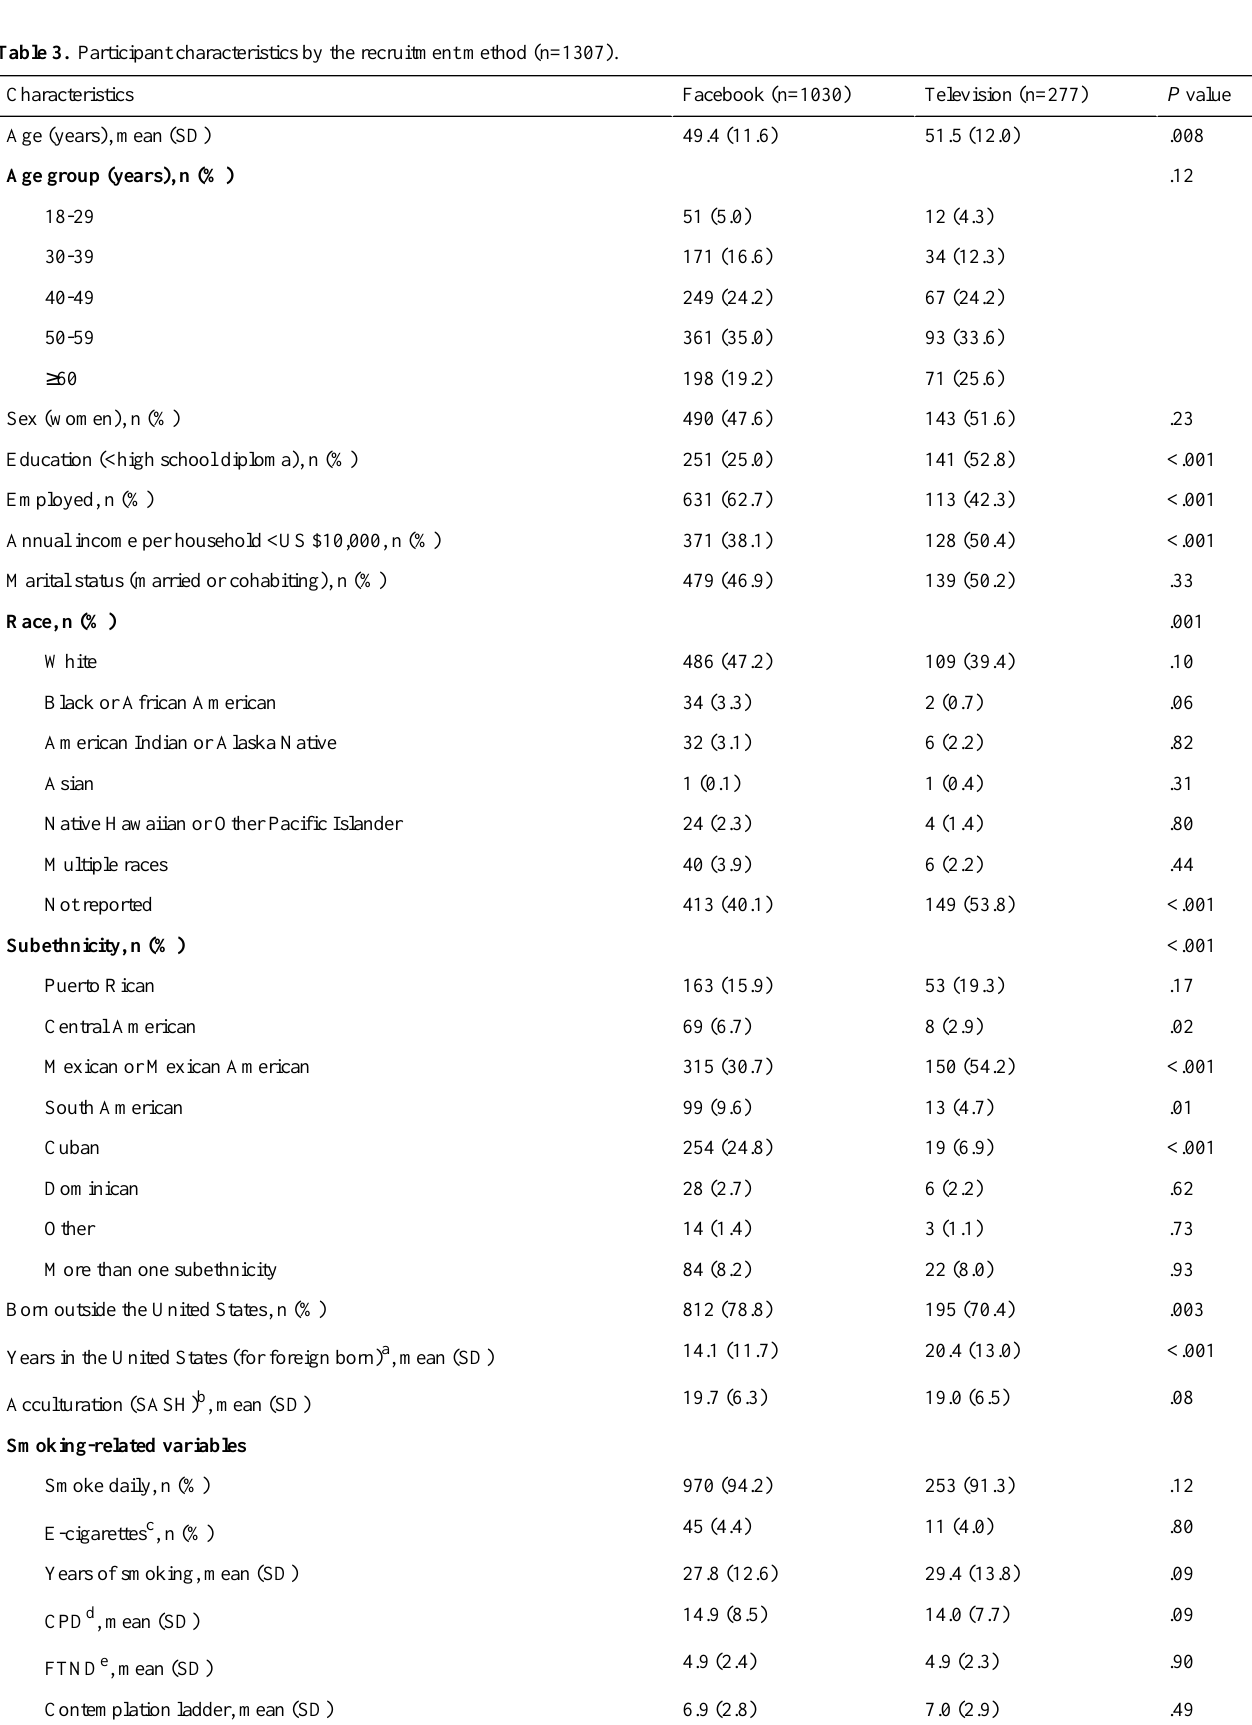
Table 3. Participant characteristics by the recruitment method (n=1307).